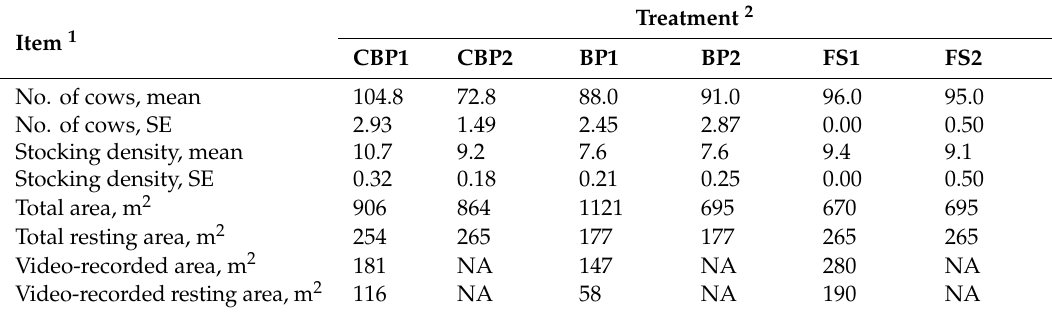
Table 2. Descriptive variables recorded over the study period in the compost bedded pack barns, bedded pack barns and freestalls.